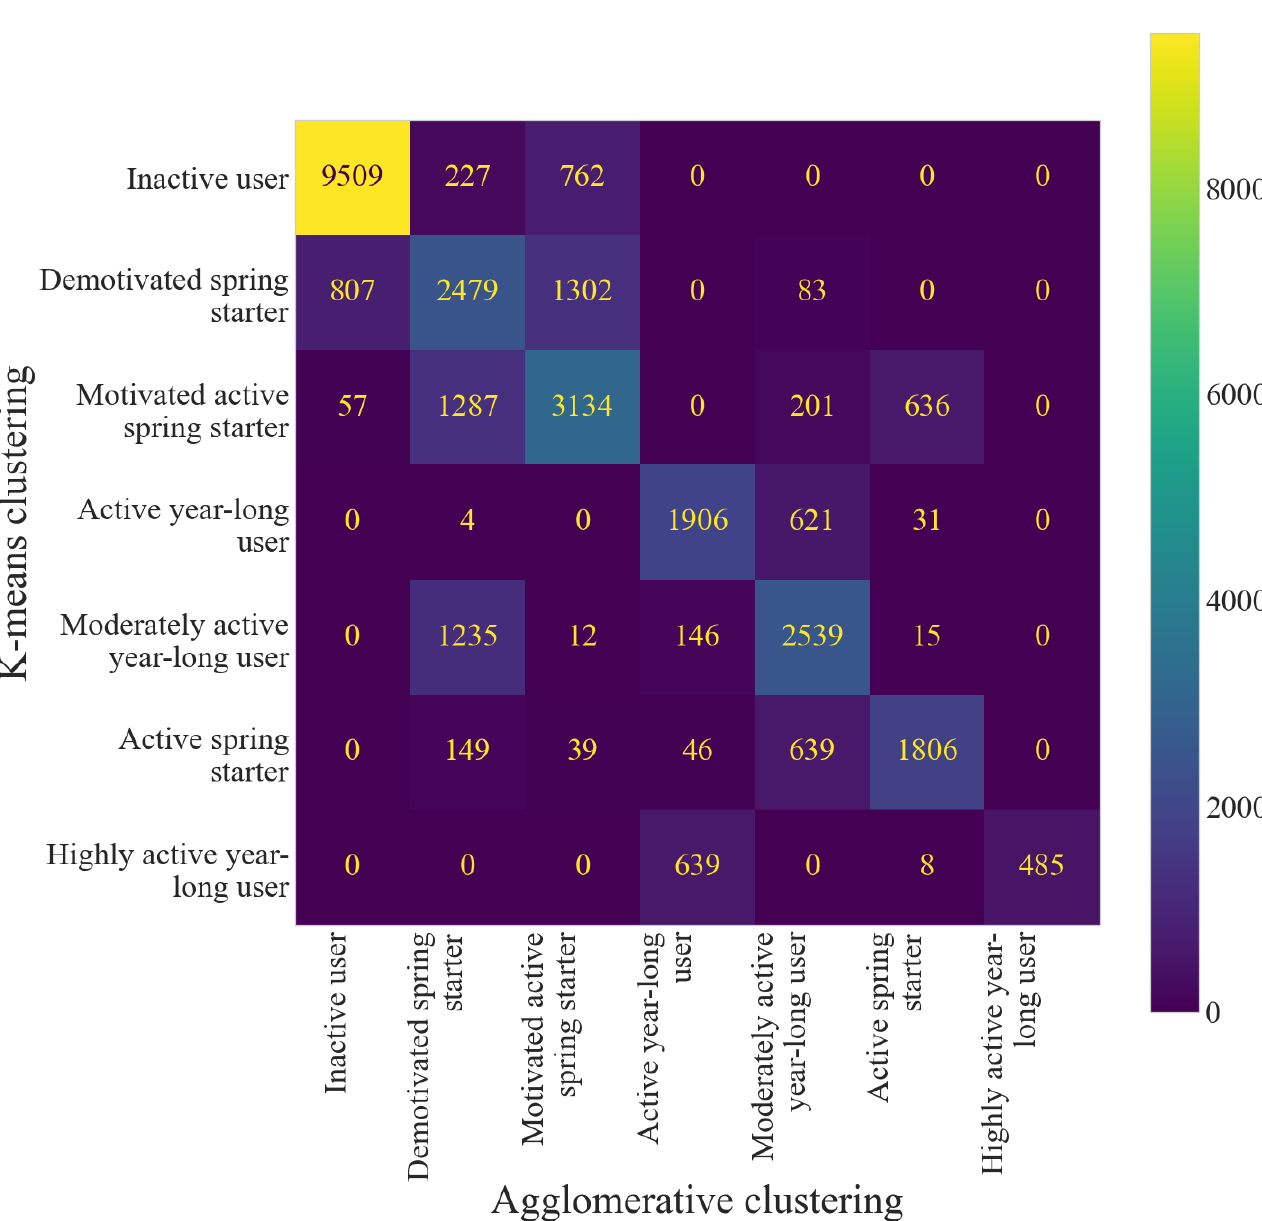
Figure A4. Confusion matrix outlining the agreement between the two clustering